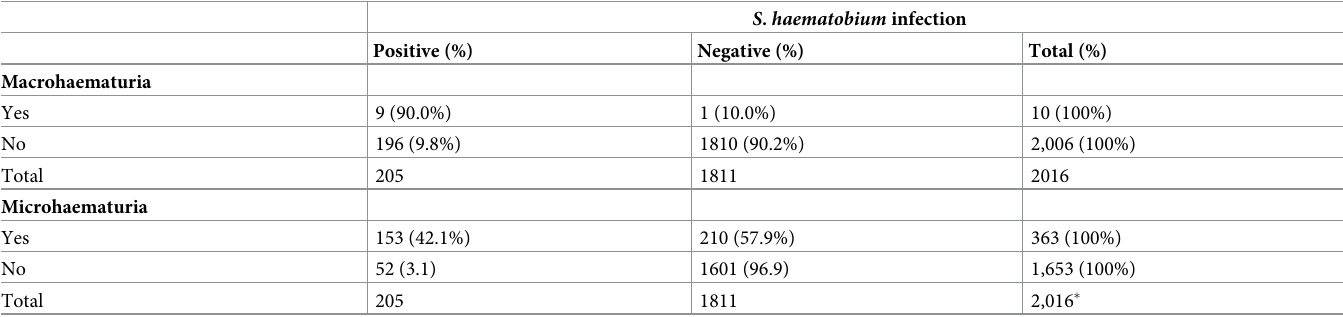
Fig 4. Infection intensity of S . haematobium (light against heavy infection) among children from 40 primary schools in 4 regions of The Gambia. https://doi.org/10.1371/journal.pntd.0009380.g004 were in the same school, while the other two infected cases were in two different schools (one case each). The only school with S . mansoni infection in URR had just one student infected. The mean (SD) egg count for S . haematobium was 6.15 (40.955). Of the 205 individuals infected with S . haematobium , 150 (73.2%) had ‘light infection’ (1–49 eggs/10 ml of urine), and 55 (26.8%) manifested ‘heavy infection’ ( � 50 eggs/10 ml of urine), see Fig 4. All the par- ticipants infected with S . mansoni , presented ‘light infection’ intensity ( < 400 eggs/g of faeces). Males had significantly higher infection intensity than females for S . haematobium (Mann- Whitney Test = 493170.0, p = 0.030). There was no significant difference in S . haematobium egg counts among age groups (Kruskal-Wallis Test, chi-square = 1.016, df = 2, p = 0.602). A Spearman’s correlation analysis found a positive correlation between prevalence of S . haemato- bium infection and egg intensity (r = 0.995, p < 0.001). Macro and microhaematuria Overall, 10 (0.5%) individuals had visible blood in their urine or macrohaematuria, with 9 (90%) of them positive for S . haematobium eggs. Of the 2,006 participants negative for macro- haematuria, only 9.8% (196) had eggs in their urine (Table 2). Fisher’s Exact Test showed a Table 2. Frequency of macro and microhaematuria among the studied school children,